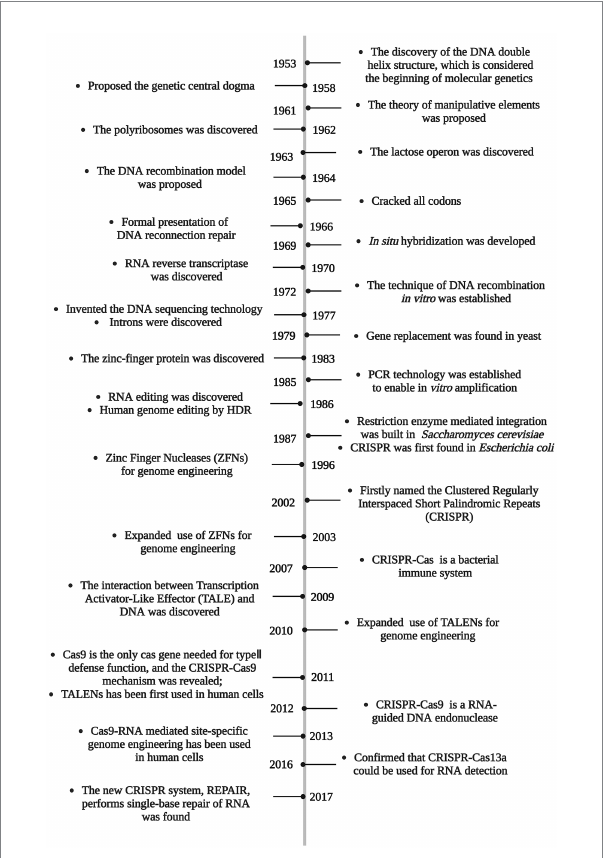
FIGURE 1 The history of gene editing